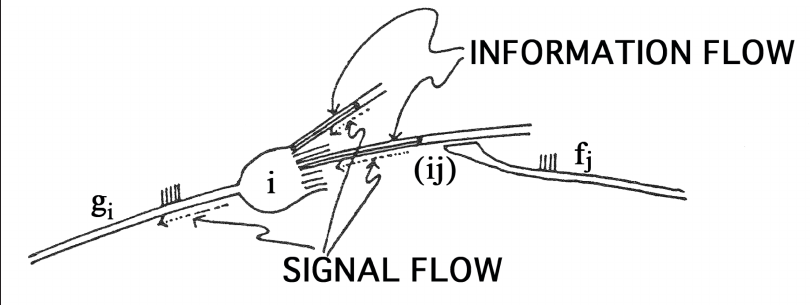
Figure 1 | in order that the junction (ij) be modified in proportion to g communicating the firing rate g A f back to the junction ∑ j ij j